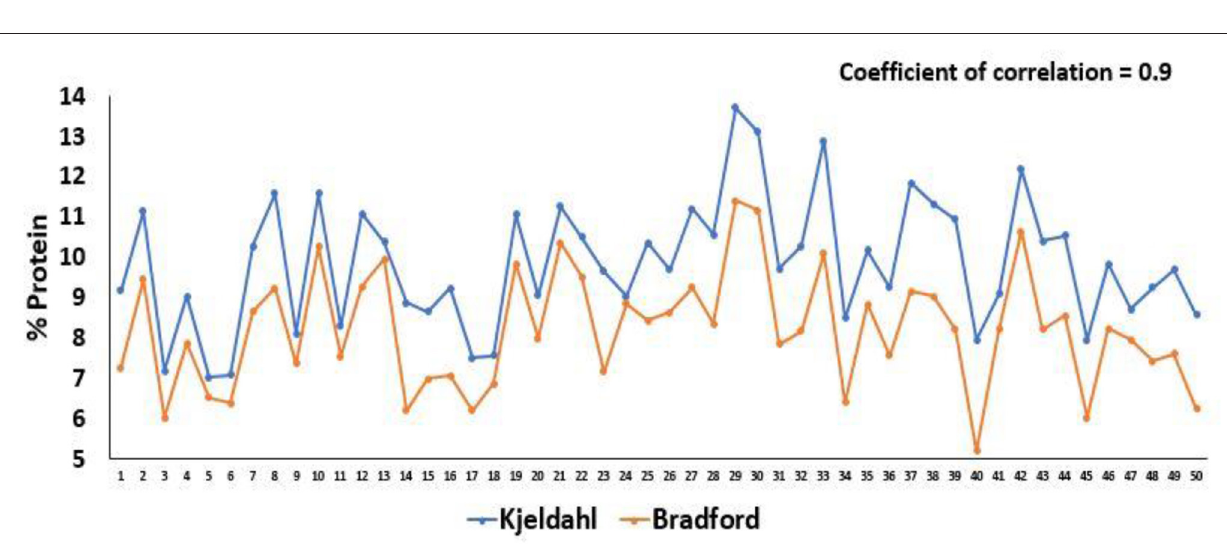
To solubilize the glutelins and zeins, a sequential extraction using alkali and alcohol was employed. The extraction protocol involved sonication for 30 min with 0.1 N NaOH (pH